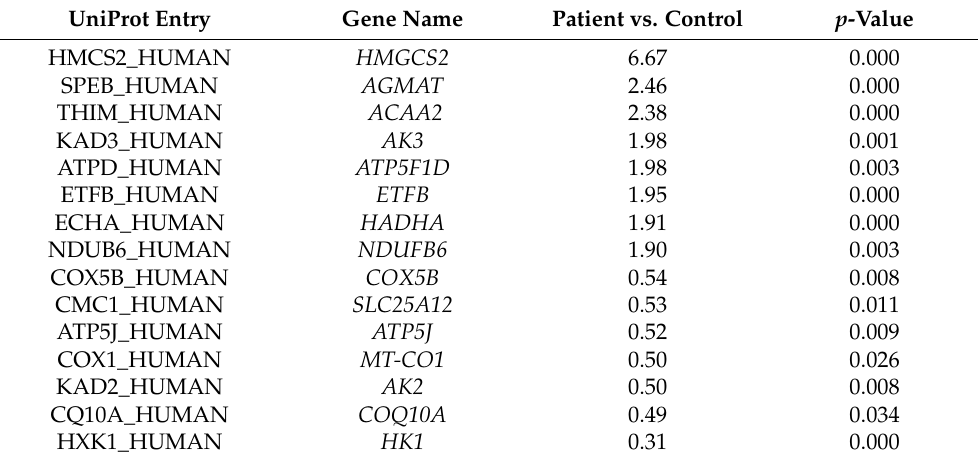
Table 1. Dysregulated proteins within the patient’s muscle biopsy showing mitochondrial